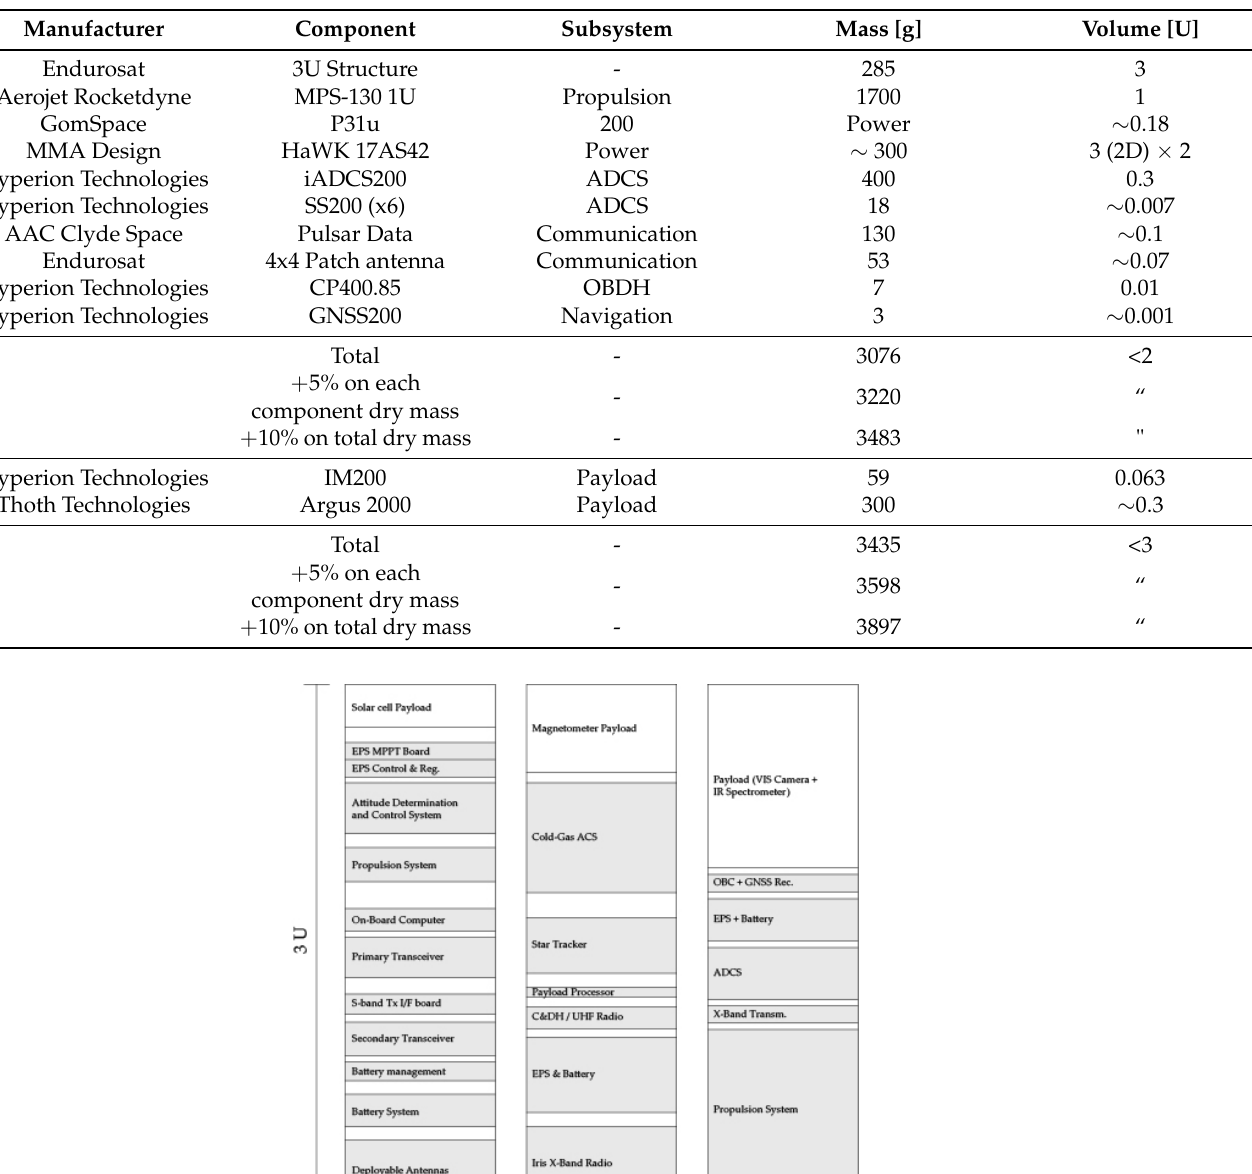
Table 7. Mass and volume budgets.